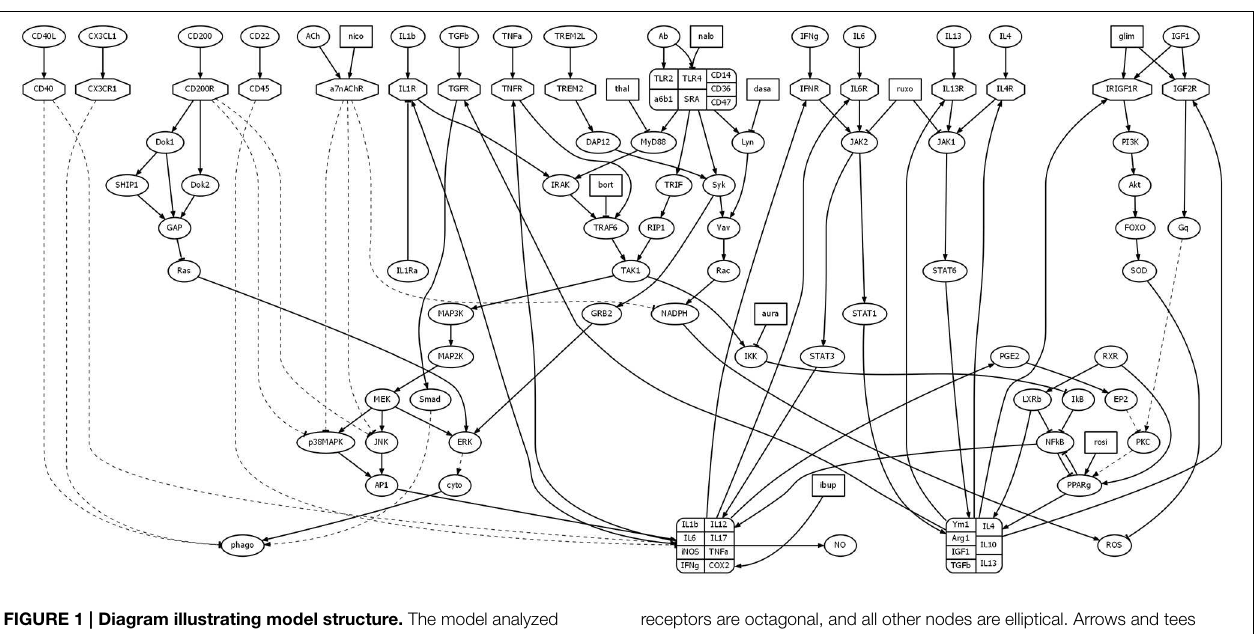
receptors are octagonal, and all other nodes are elliptical. Arrows and tees represent activating and suppressing connections, respectively. Solid and dashed curves represent direct and indirect connections, respectively. For abbreviations see Table 1 or Anastasio